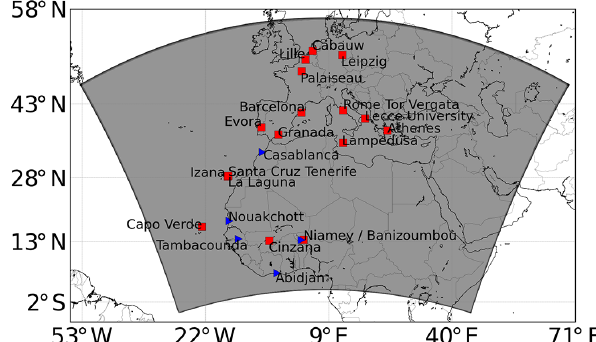
faster than the WRF model, the CHIMERE model would wait for WRF meteorological fields.